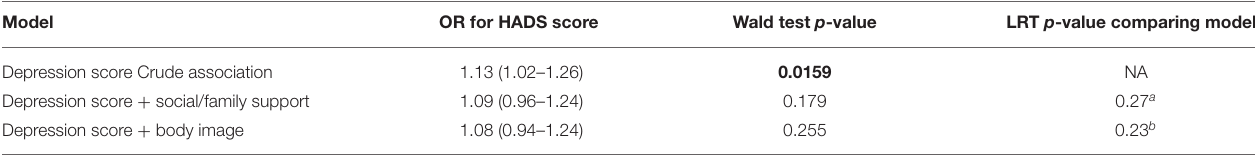
TABLE 4 | Comparison of models of association between depression and non-adherence with and without adjustment for potential confounders. Model OR for HADS